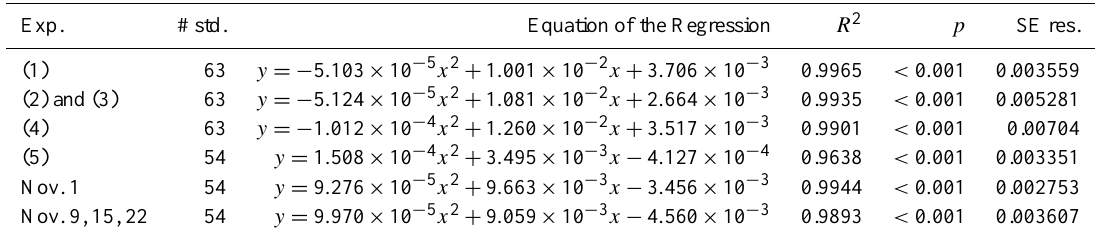
Table 3. Equations of the regressions of the StS of each experiment (Exp.), number of standards (# std.) analysed, standard deviation ( R 2 ) , probability ( p ), and standard error of the residuals (SE res.) associated with the regression. Exp. # std. Equation of the